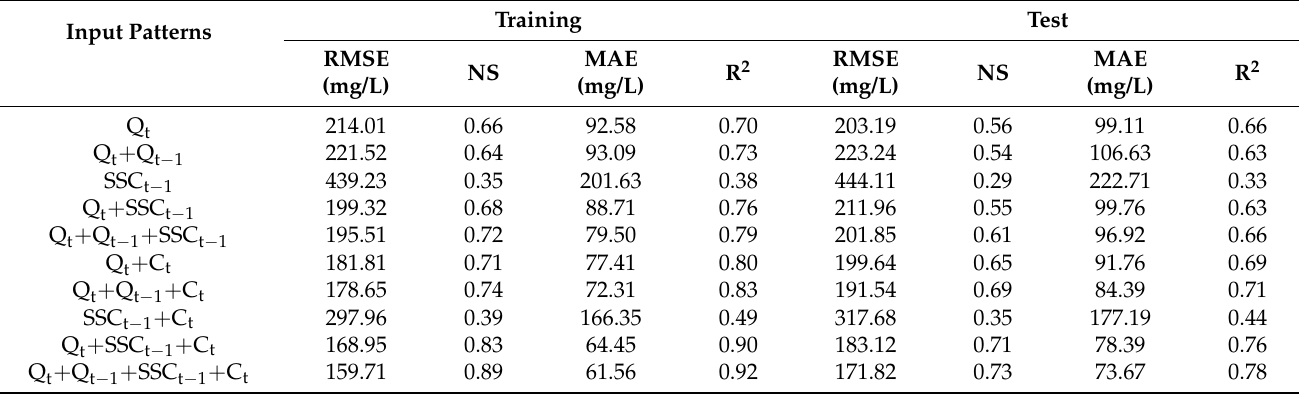
Table 5. Results of monthly SSC modeling by SVR with different input patterns during training and test phases.